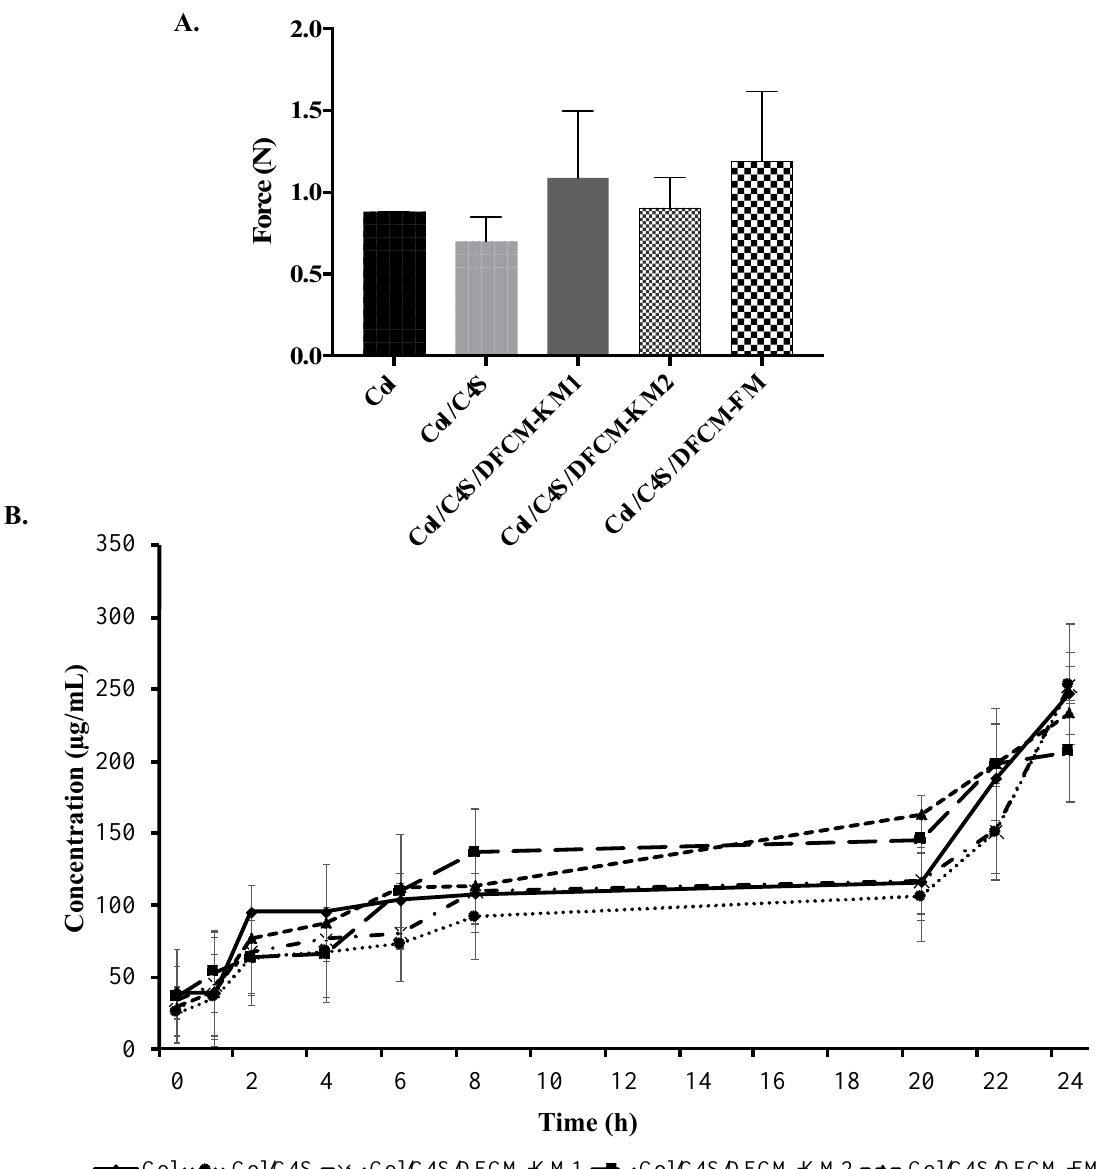
Figure 5. ( A ) Mechanical strength of the constructs. All constructs had force of <2.5 N, indicating that they were soft collagen hydrogel constructs. ( B ) Protein release from the constructs showing the same release pattern, i.e., the protein concentrations increased with incubation time.